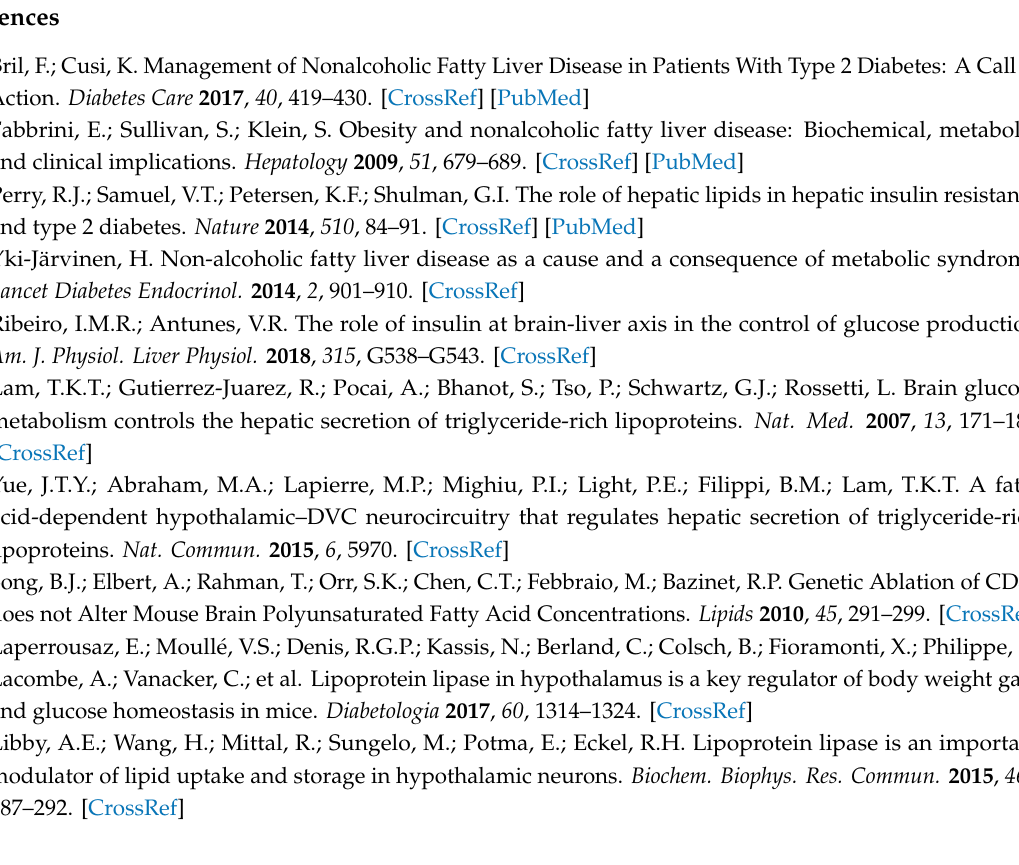
Figure S1: Analysis of metabolites in the glycolysis pathway in immortalized hypothalamic neurons either over expressing lipoprotein lipase (LPL) (LPL OE) versus empty vector control cells (Emp) and LPL knock-down cells (LPL KD) versus 202 control cells (202 control). Figure S2: Analysis of metabolites in the TCA pathway in immortalized hypothalamic neurons either over expressing lipoprotein lipase (LPL) (LPL OE) versus empty vector control cells (Emp) and LPL knock-down cells (LPL KD) versus 202 control cells (202 control). Figure S3: Analysis of fatty acid metabolites in immortalized hypothalamic neurons either over expressing lipoprotein lipase (LPL) (LPL OE) versus empty vector control cells (Emp) and LPL knock-down cells (LPL KD) versus